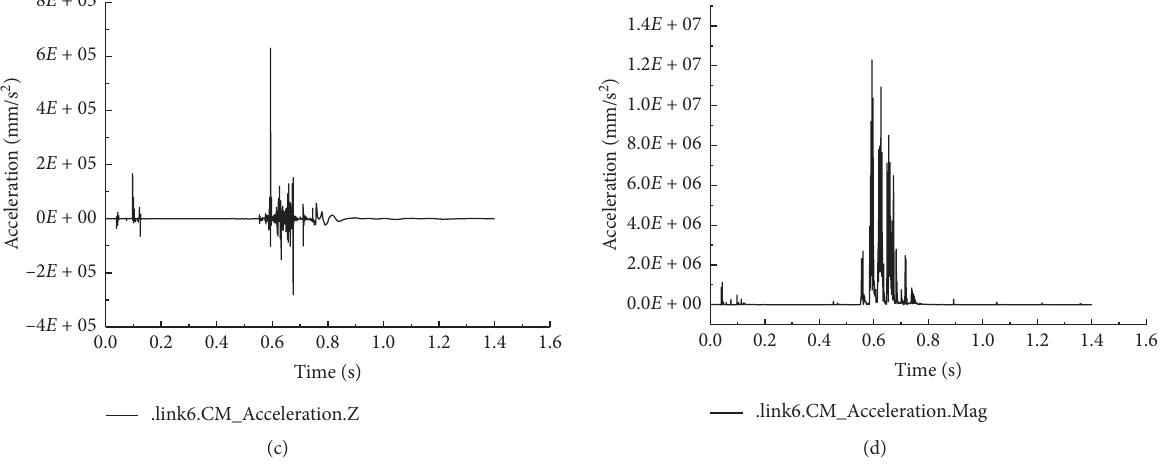
Figure 8: Link 6 acceleration change curve. (a) Acceleration in the X direction. (b) Acceleration in the Y direction. (c) Acceleration in the Z direction. (d) Acceleration amplitude.